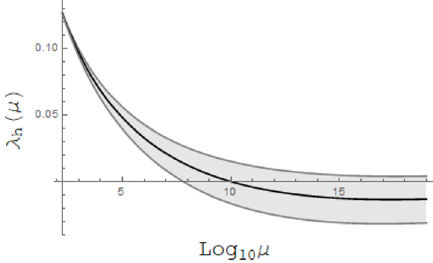
Figure 2 . Running of the Higgs quartic coupling up to the Planck scale M p = 2 : 4 (cid:2) 10 18 GeV. The current experimental central values from ref. [63] were used as input parameters with the top quark pole mass, m t , varied within its 3 (cid:27) experimental constraints: m t = 173 : 1 (cid:6) 0 : 9 GeV. The upper bound corresponds to m t = 170 : 4 GeV and the lower bound m t = 175 : 8